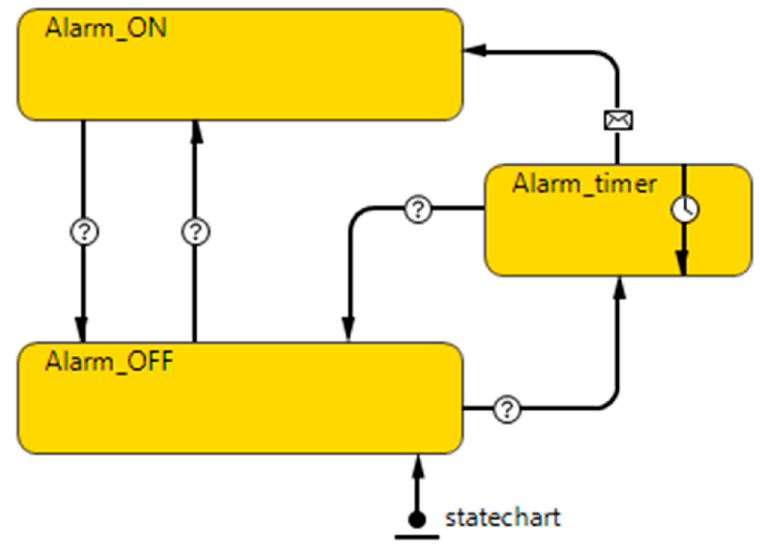
Figure 3. Production-environment alarm logic.